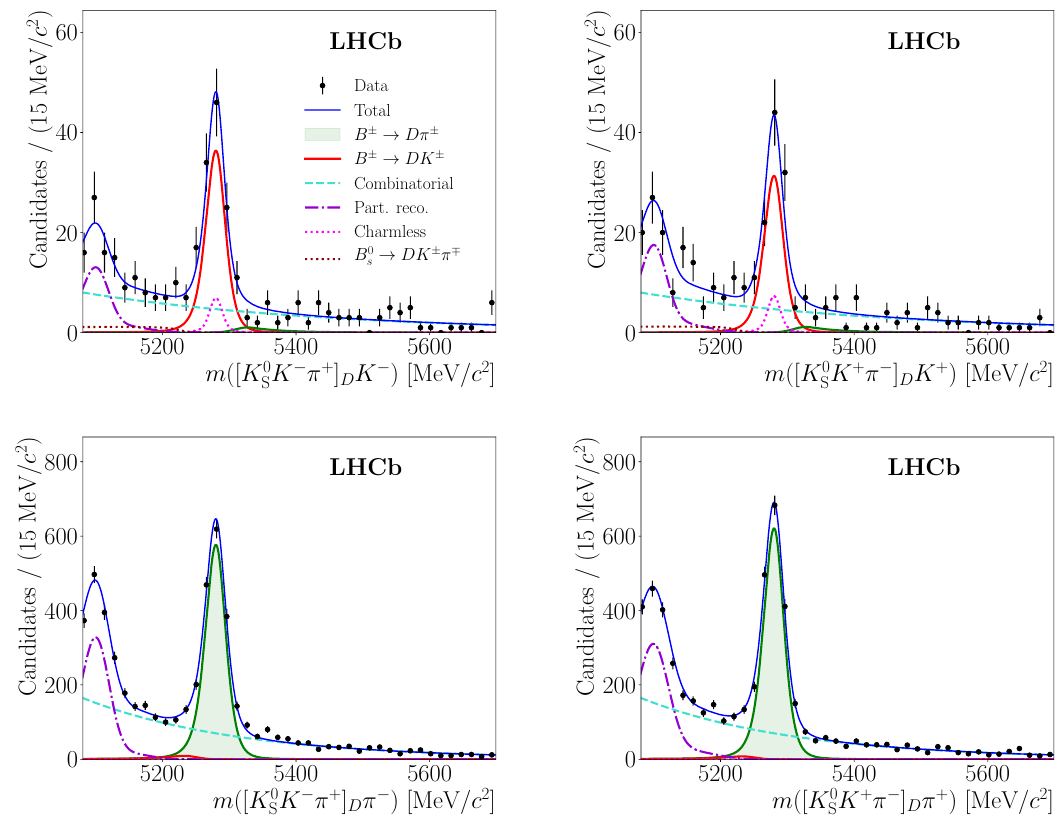
[ K 0 K (cid:6) (cid:25) (cid:7) ] D h (cid:6) candidates in the non- K (cid:3) + region. The (cid:12)t S !